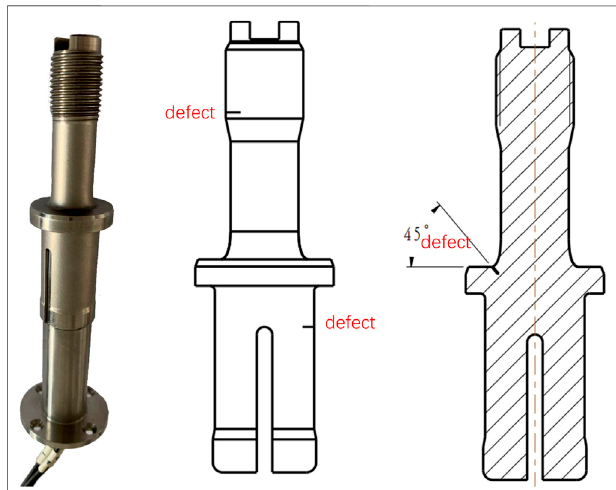
FIGURE 7 | Transducer testing using the blocks with